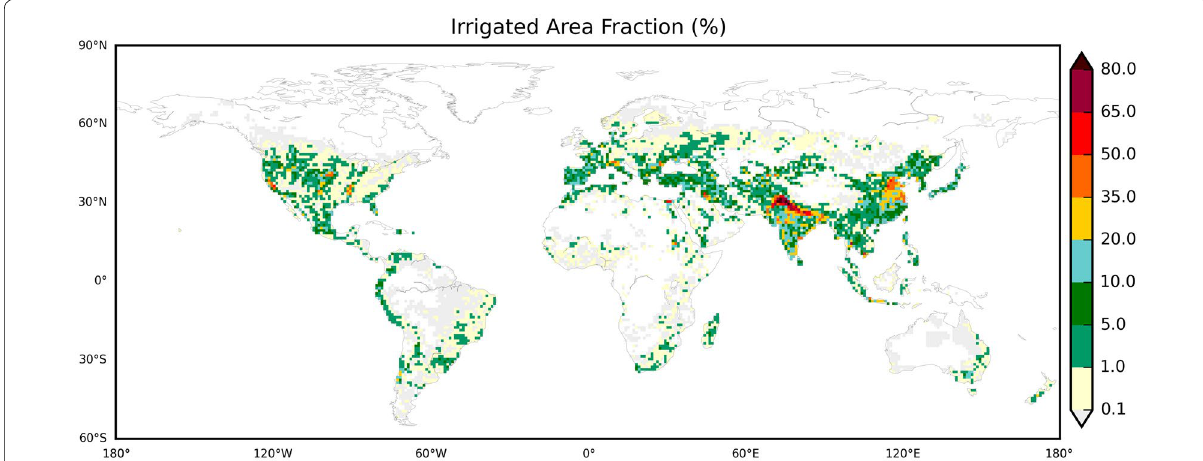
Fig. 5 Irrigated area fraction at 1° grids. White color represents either ocean or land not equipped for irrigation. Data source: Siebert et al. (2015). While color represents ocean or land without irrigated areas